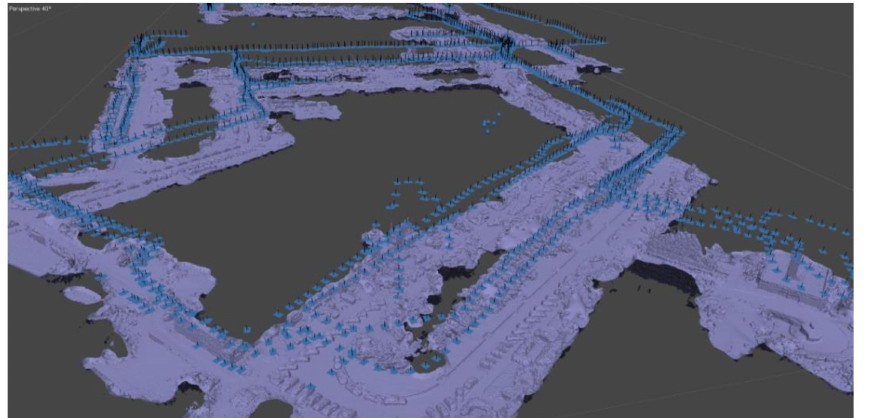
Figure 3. Digital model of the area with individual images.